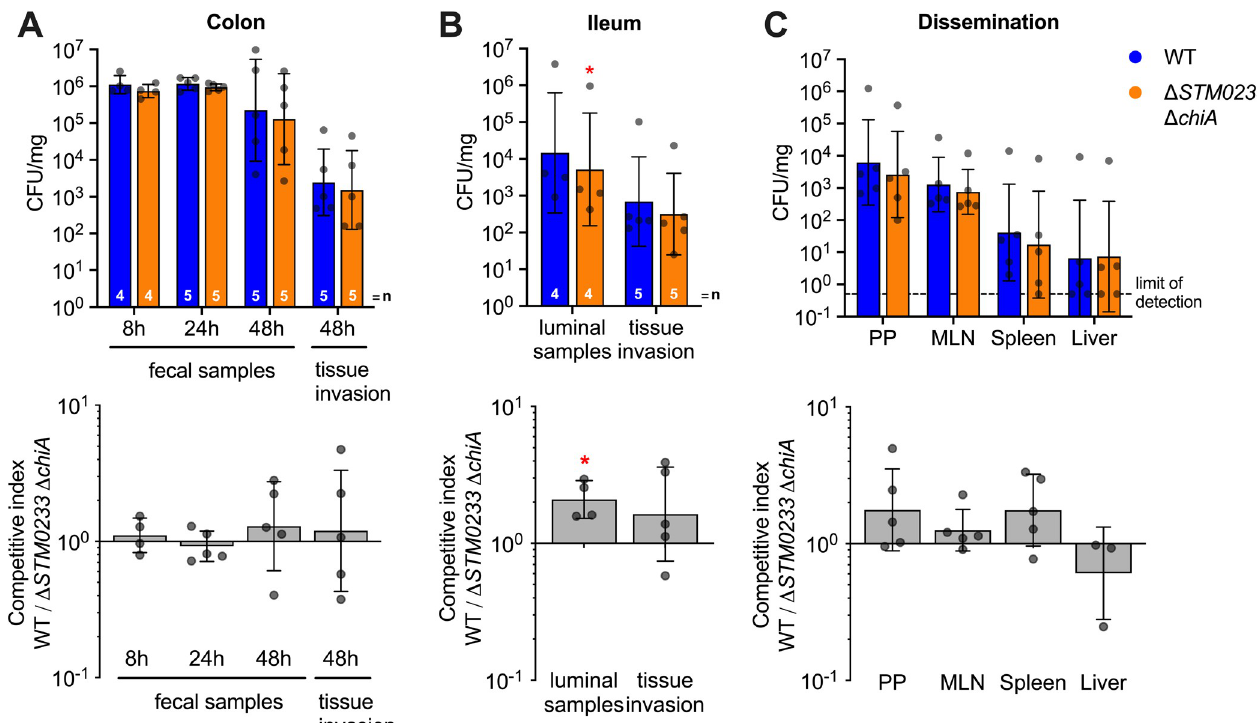
Fig 5. The presence of WT S . Typhimurium rescues the invasion of chitinase-deficient S . Typhimurium. Mice infected by oral gavage with a 1:1 ratio of WT and chitinase-deficient S . Typhimurium. (A) S . Typhimurium colonies recovered from fecal samples collected at 8 and 24 hpi. Fecal samples at 48 hpi were collected directly from the lumen of the colon. Invasion of colonic tissue was determined with a gentamicin protection assay. (B) Luminal samples from the terminal ileum were collected 48 hpi to determine S . Typhimurium colonization. Invasion was determined with a gentamicin protection assay performed on the terminal ileum. (C) Colonization of the Peyer’s patches (PP), mesenteric lymph nodes (MLN), spleen, and liver 48 h after intragastric infection. n = 5. Top panels A-C: CFU/mg recovered for WT and chitinase-deficient S . Typhimurium. Bars represent geometric mean ± geometric SD. Bottom panels A-C: the same data expressed as a competitive index, CI = (WT colonization/mutant colonization)/ (WT inoculum/mutant inoculum). Bars represent geometric mean ± geometric SD. Statistics: (Top Row) Paired t- test was performed with the absolute values (Bottom Row) the competitive index was analyzed with a one- sample t -test against our null hypothesis (competitive index = 1). � = p <